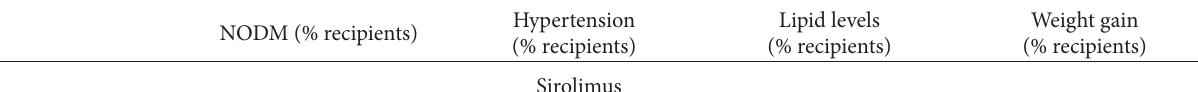
Table 5: Effect of mTOR inhibitors on components of metabolic